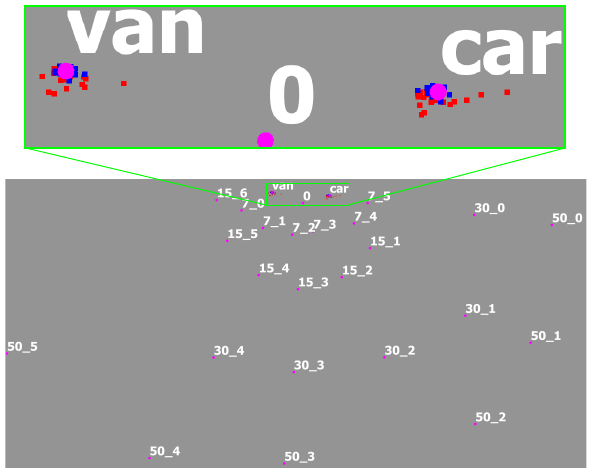
Figure 3. Bottom: the different locations of the scanner and car/van positions during the measurements (magenta). Top: the detections using the BC-PCA (blue) and ASM (red) in the HDL-64 scans